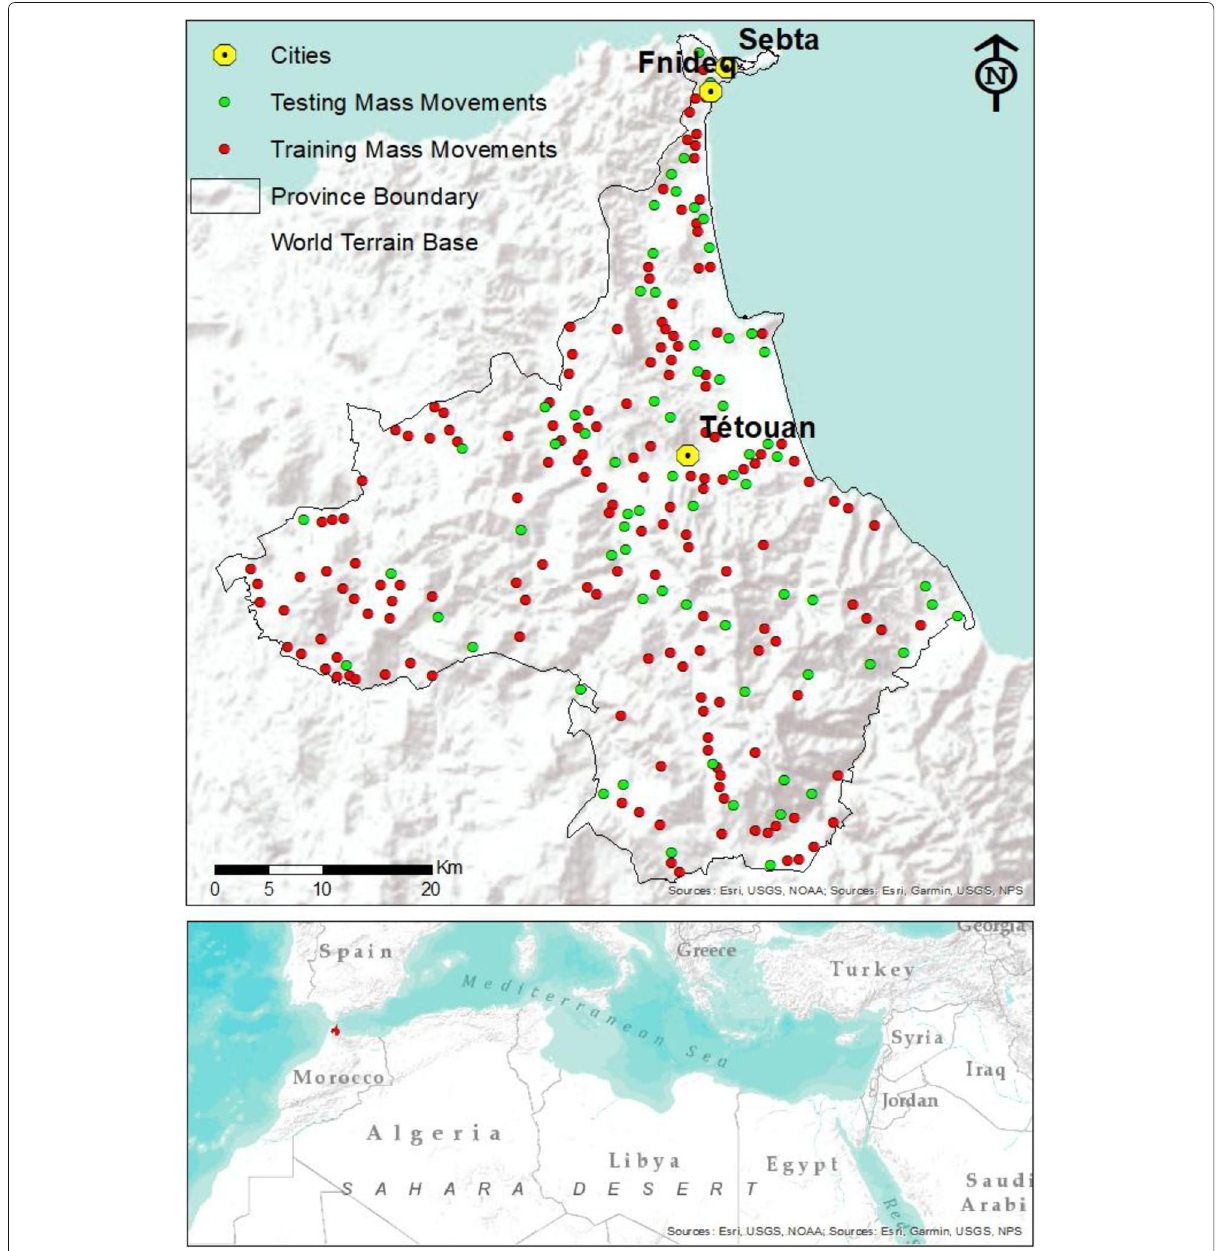
Fig. 1 Location of the study area and the distribution of mass movements